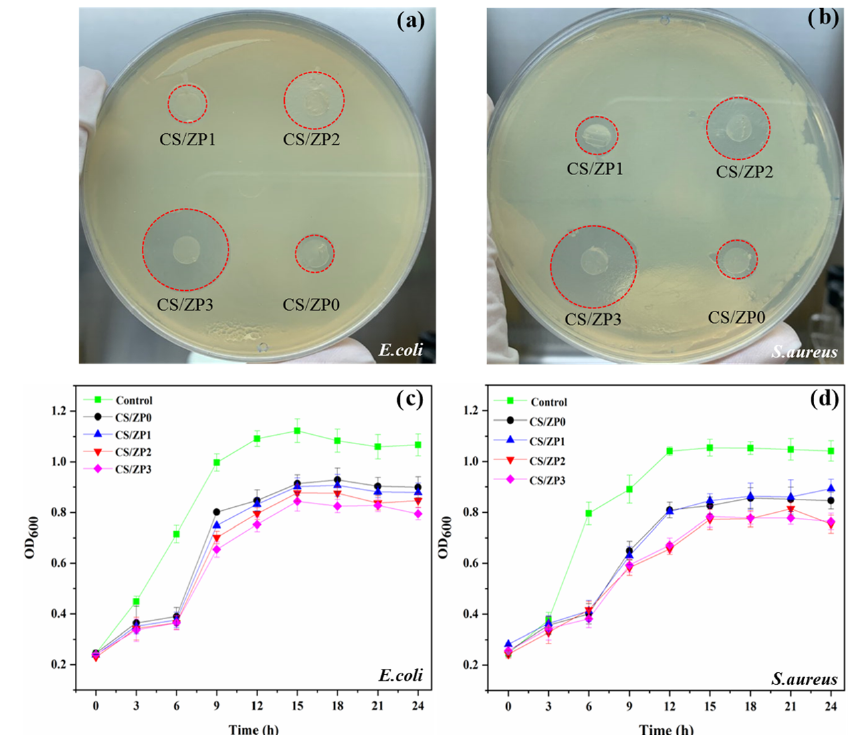
Figure 7. Inhibitory zone of bionanocomposite films against ( a ) E. coli and ( b ) S. aureus and optical density measurement of bacteria at a wavelength of 600 nm (OD600) for ( c ) E. coli and ( d ) S. aureus